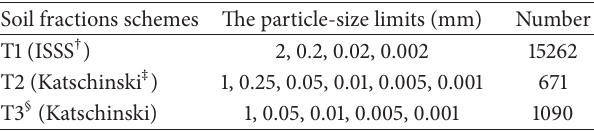
Table 1: Soil particle-size data used in this study.